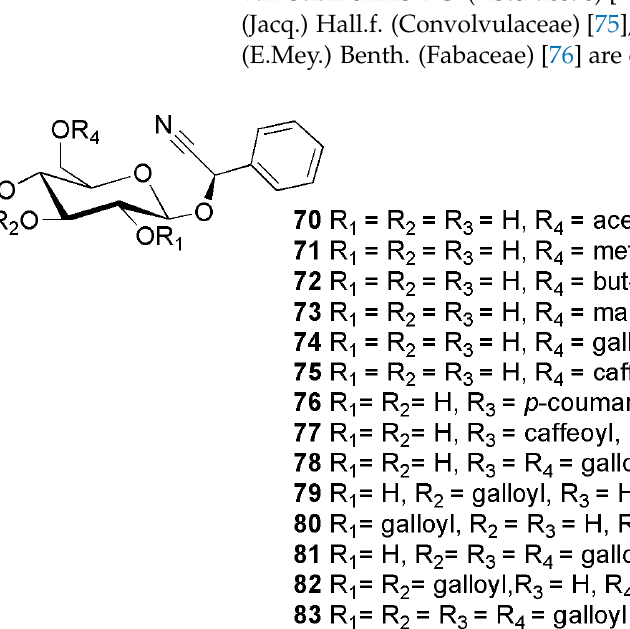
Figure 13. Cyanogenic glycosides group C-3, acyl derivatives of prunasin ( 54 ) and sambunigrin ( 55 ): peregrinumcin A ( 70 ), prunasin 6 (cid:48) - O -methacrylate ( 71 ), prunasin 6 (cid:48) - O -trans-2-butenoate ( 72 ), prunasin-6 (cid:48) - O -malonate ( 73 ) (2 R )-prunasin 6 (cid:48) - O -gallate ( 74 ), grayanin ( 75 ), prunasin 4 (cid:48) - O - p -coumarate ( 76 ), prunasin 4 (cid:48) - O -caffeate ( 77 ), prunasin 4 (cid:48) ,6 (cid:48) -di- O -gallate ( 78 ), prunasin 3 (cid:48) ,6 (cid:48) -di- O -gallate ( 79 ), prunasin 2 (cid:48) ,6 (cid:48) -di- O -gallate ( 80 ), prunasin 3 (cid:48) ,4 (cid:48) ,6 (cid:48) -tri- O -gallate ( 81 ), prunasin 2 (cid:48) ,3 (cid:48) ,6 (cid:48) -tri- O - gallate ( 82 ), prunasin 2 (cid:48) ,3 (cid:48) ,4 (cid:48) ,6 (cid:48) -tetra- O -gallate ( 83 ) and (2 S )-6 (cid:48) - O -galloylsambunigrin ( 84 ).